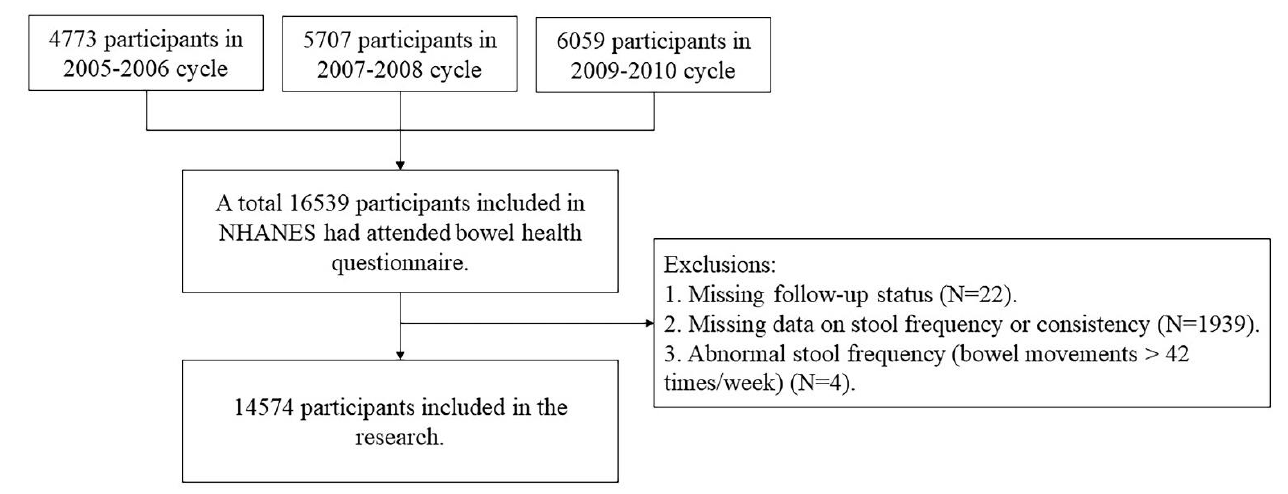
Figure 1. Flowchart of participants included and excluded in the final analysis (N =